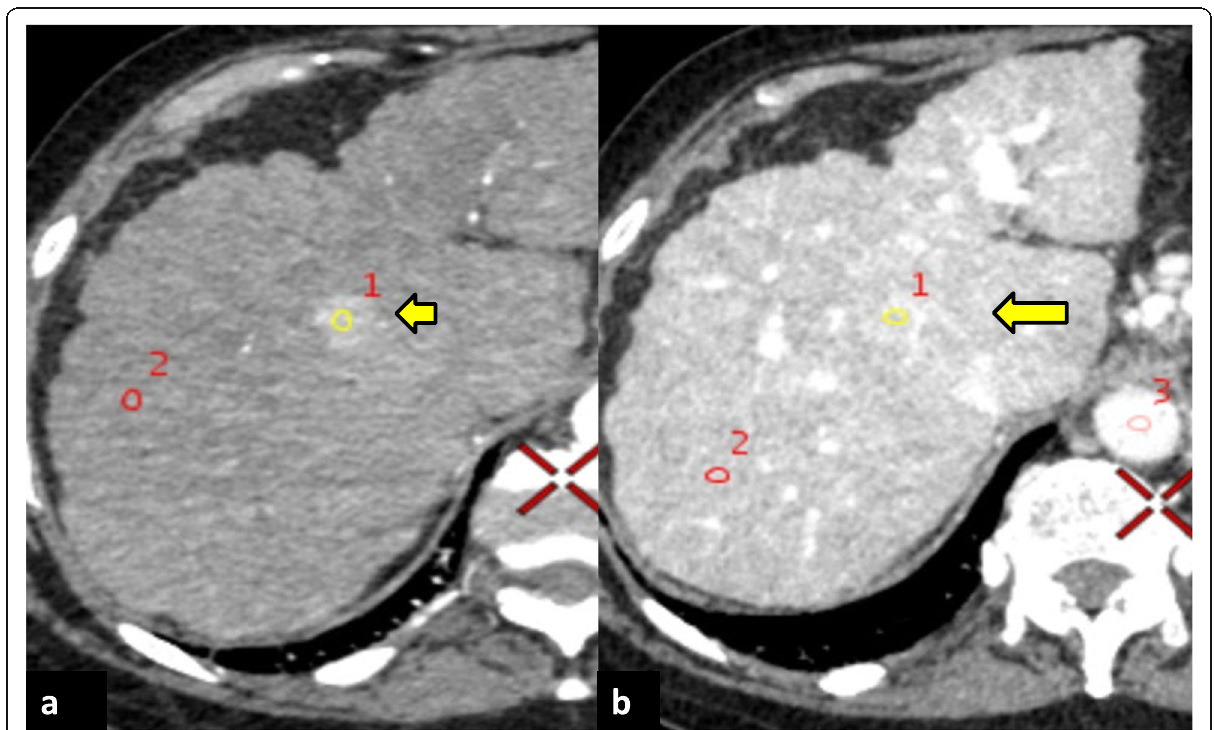
Fig. 4 Computed tomography of a patient with underlying cirrhosis depicting an ‘ indeterminate ’ nodule. a Polychromatic axial image on HAP depicting a hypervascular nodule (yellow ROI), in segment VIII (yellow arrow). b Polychromatic axial image on PVP of the same nodule shows persistent enhancement without overt washout (yellow ROI) in segment VIII (yellow